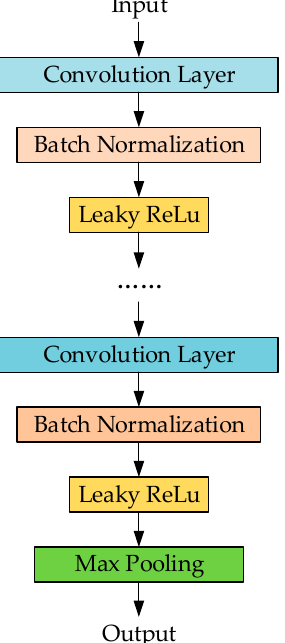
Figure 14. Block structure diagram. Each block is composed of multiple convolutional layers, batch standardization, and activation functions. Before the output of the block, feature filtering and data compression are carried out through the pooling layer.